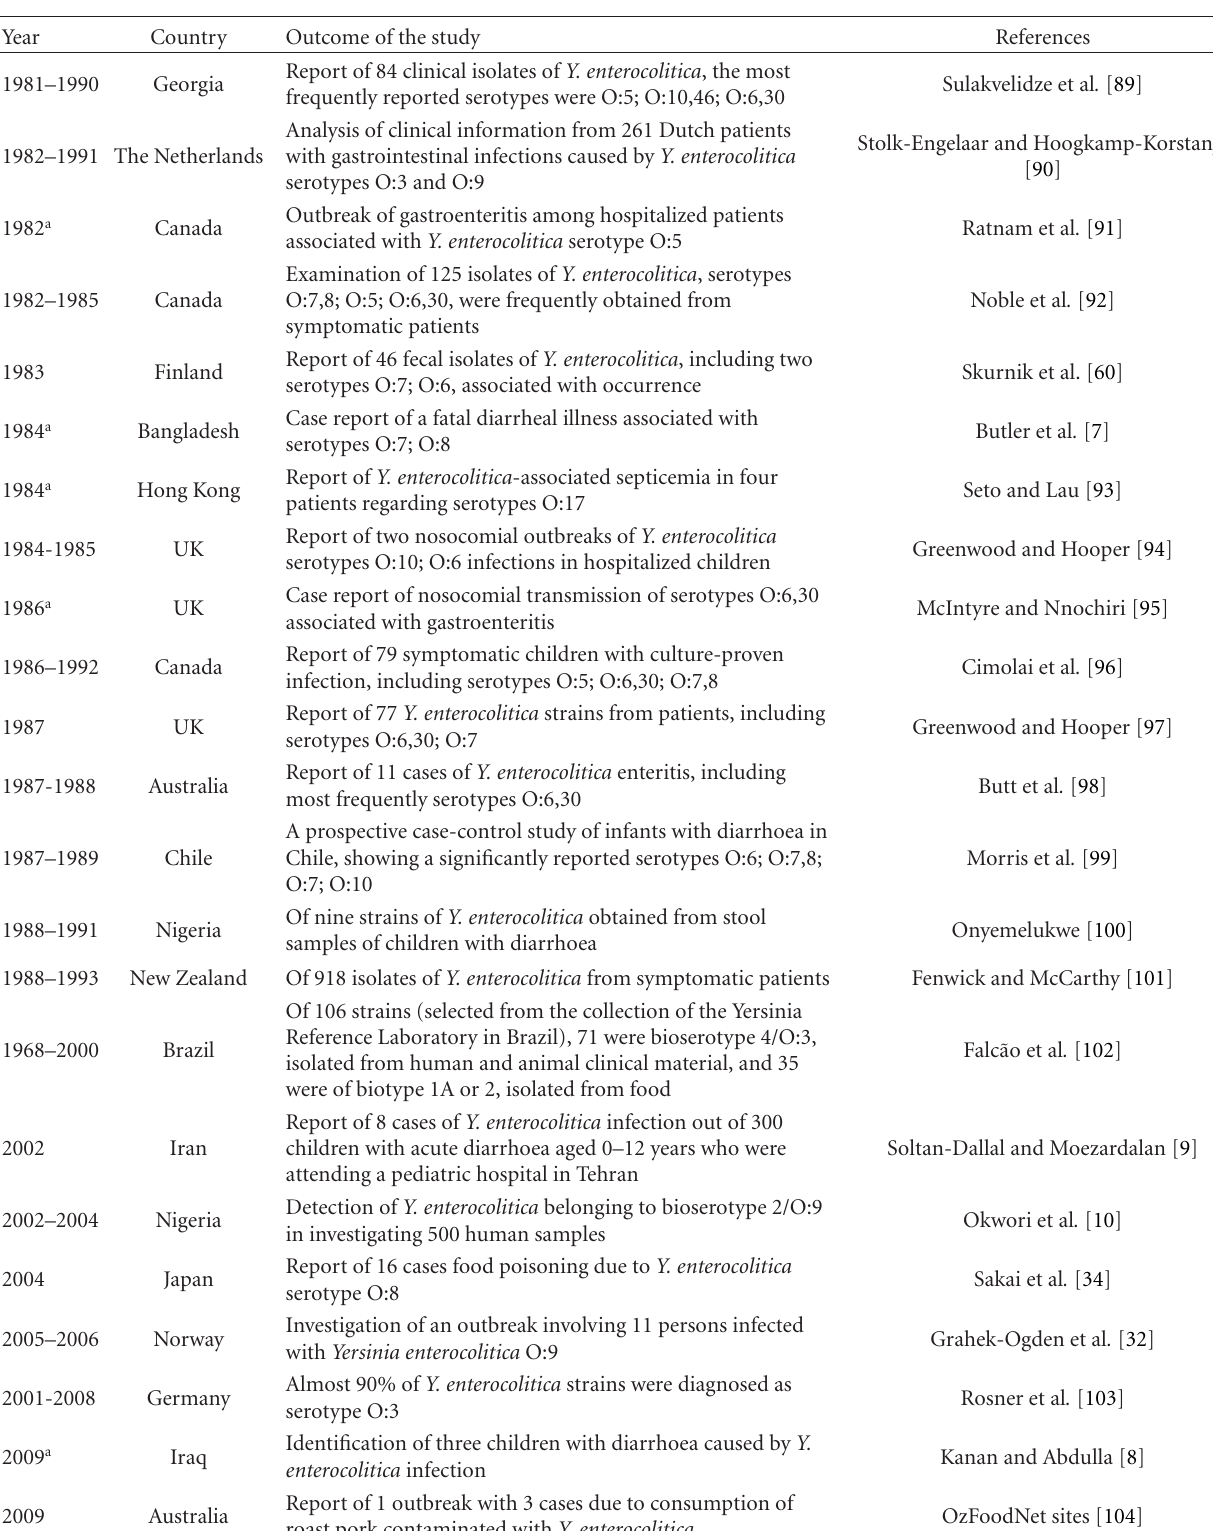
Table 3: Epidemiological studies of human infection with Y. enterocolitica